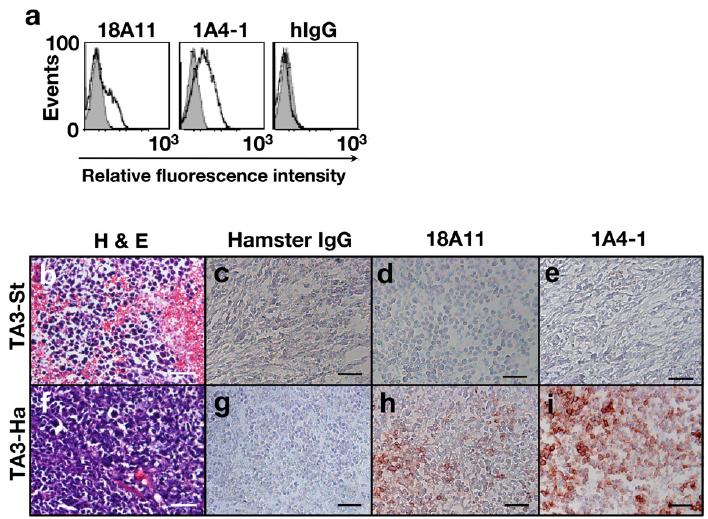
Figure 5. Characterization of TA3 mammary carcinoma cells and breast cancer tissue generated via the injection of TA3 cells into mammary fat pads of 5-week-old A/J mice. ( a ) FACS analysis with ( left ) mAb 18A11, ( middle ) mAb 1A4-1, and ( right ) hamster IgG. In each case, the shaded area represents antibody binding to TA3-St cells and the black line represents antibody binding to TA3- Ha cells. ( b ) Hematoxylin and eosin (H&E) staining of breast cancer tissue generated through the injection of TA3-St cells. ( c – e ) Tissue sections of breast cancer generated from TA3-St cells stained with ( c ) hamster IgG, ( d ) mAb 18A11, and ( e ) mAb 1A4-1. ( f ) H&E staining of breast cancer tissue generated via the injection of TA3-Ha cells. ( g – i ) Tissue sections of breast cancer generated from TA3-Ha cells stained with ( g ) hamster IgG, ( h ) mAb 18A11, and ( i ) mAb 1A4-1. ( b – i ) Scale bar: 50 μ m. 2.5. Muc21 mRNA Expression in Normal Mouse Tissues and Immunohistochemical Staining of Normal Mouse Tissues with mAbs 1A4-1 and 18A11 To investigate the mRNA expression of Muc21 , we performed RT-PCR using a panel of normal mouse tissues. As a result, Muc21 mRNA expression was observed in tissues characterized by squamous epithelia, including vagina, esophagus, eye, stomach, and thymus tissues (Figure 6a). Based on these results, we decided to investigate whether mAbs 1A4-1 and 18A11 can detect Muc21 protein in the esophagus and vagina via immunohistochemistry using large intestine tissue as a negative control. With mAb 18A11, no antibody binding could be detected in any of the mouse tissues tested (data not shown). With mAb 1A4-1, antibody binding could only be observed after the tissue had been treated with sialidase. In sialidase-treated esophagus and vagina tissue, antibody binding was observed on the luminal side of the squamous epithelium (Figure 6b,c). No antibody binding after sialidase treatment was observed in the large intestine tissue, which served as a negative control (Figure 6d).